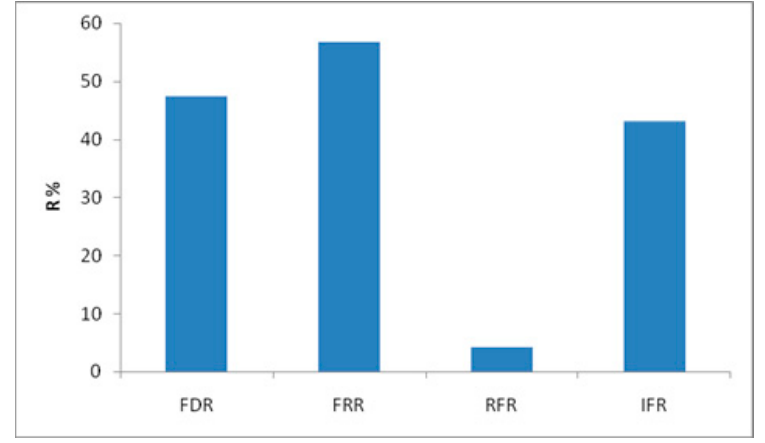
Figure 10. Permeate flux during filtration experiments with a ceramic UF membrane.